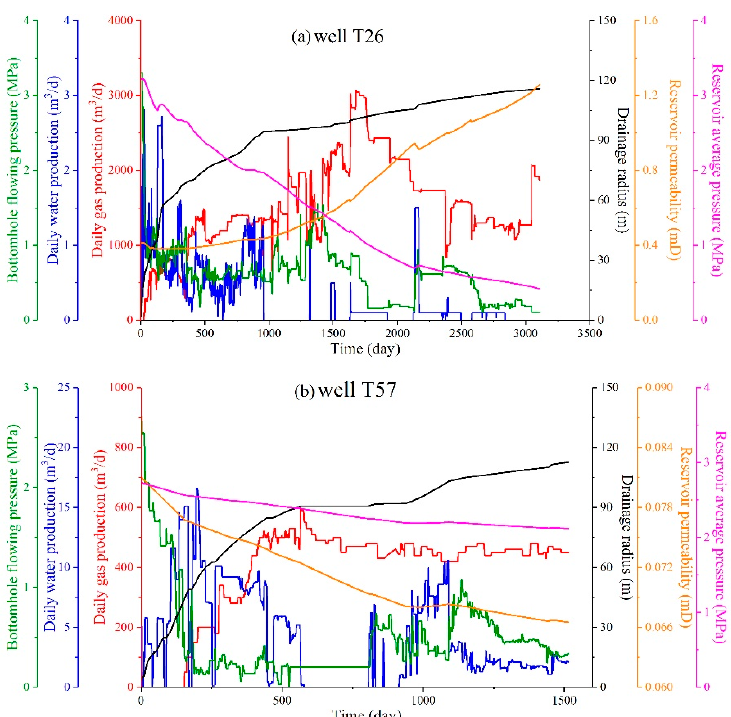
Figure 7. The actual production data and calculation results of reservoir dynamic characterization of the target wells.